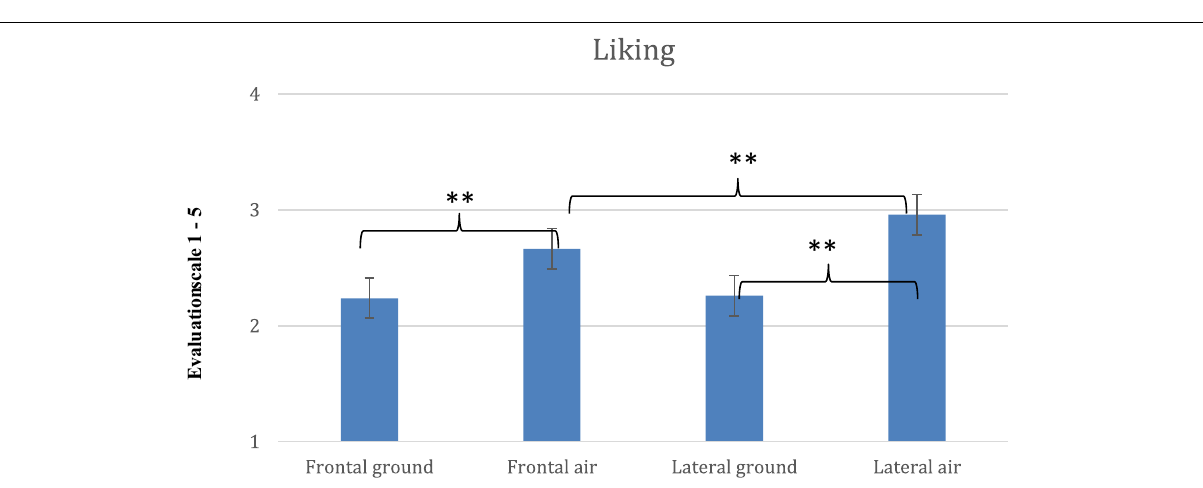
FIGURE 6 | Mean scores for Liking and significant interaction for the four poses, Frontal On- ground , Lateral On-ground , Frontal In-air and Lateral In-air (error bars indicate standard errors of the means; ∗∗ = <